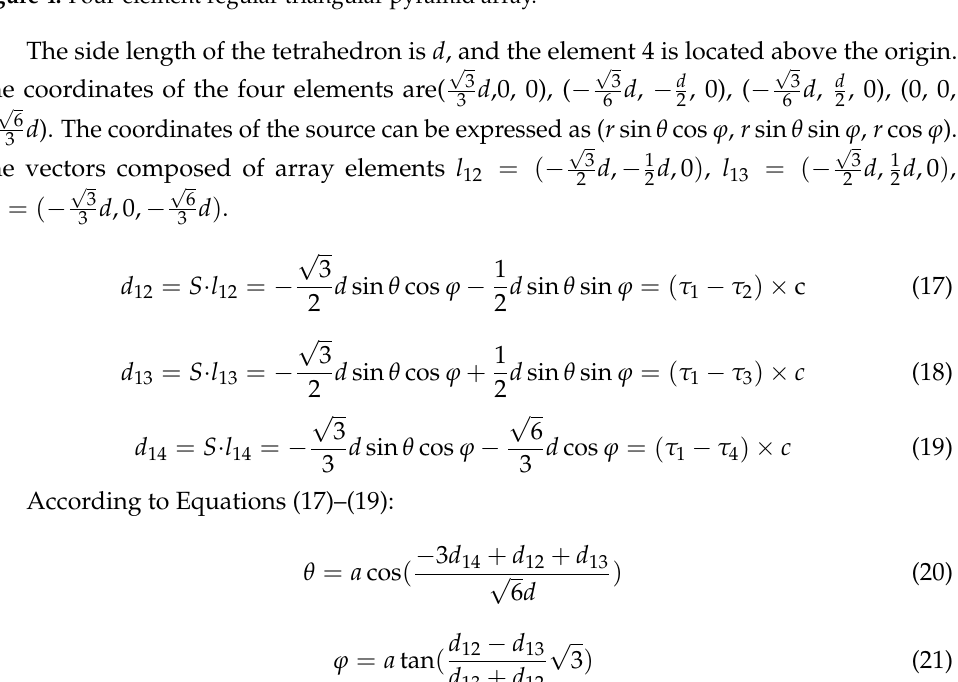
The azimuth estimation formula of the triangular pyramid array is similar to that of stereo arrays 1 and 2, which can improve the signal localization performance at a high incident angle but also has the problem of poor localization performance at a low incident angle. In order to improve this problem, a virtual array element will be introduced. The specific structure is shown in the Figure